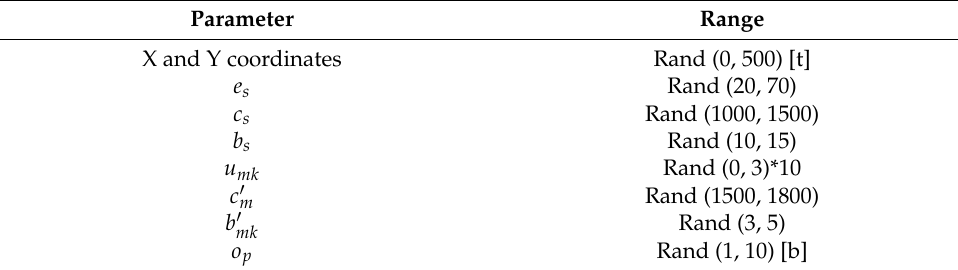
Table 2. The ranges of some parameters of instances.